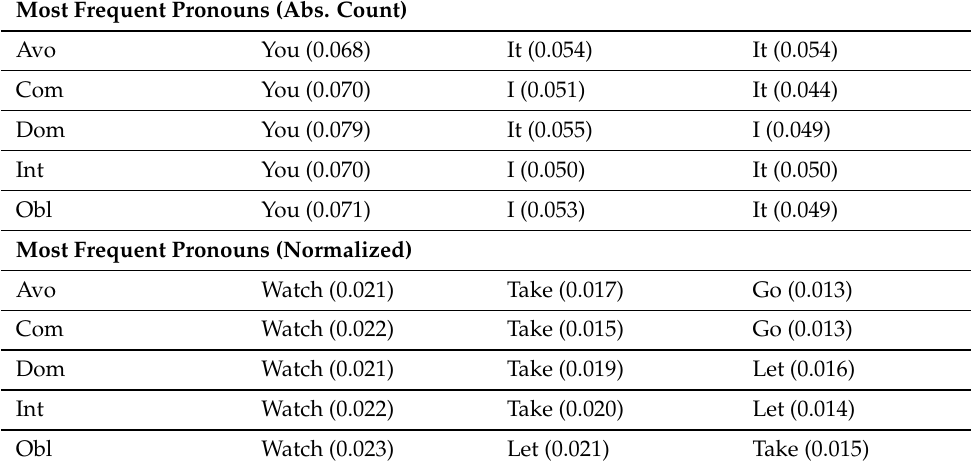
Table 7. Most frequent terms (absolute counts and normalized by the total number of words) that occurred in each of the